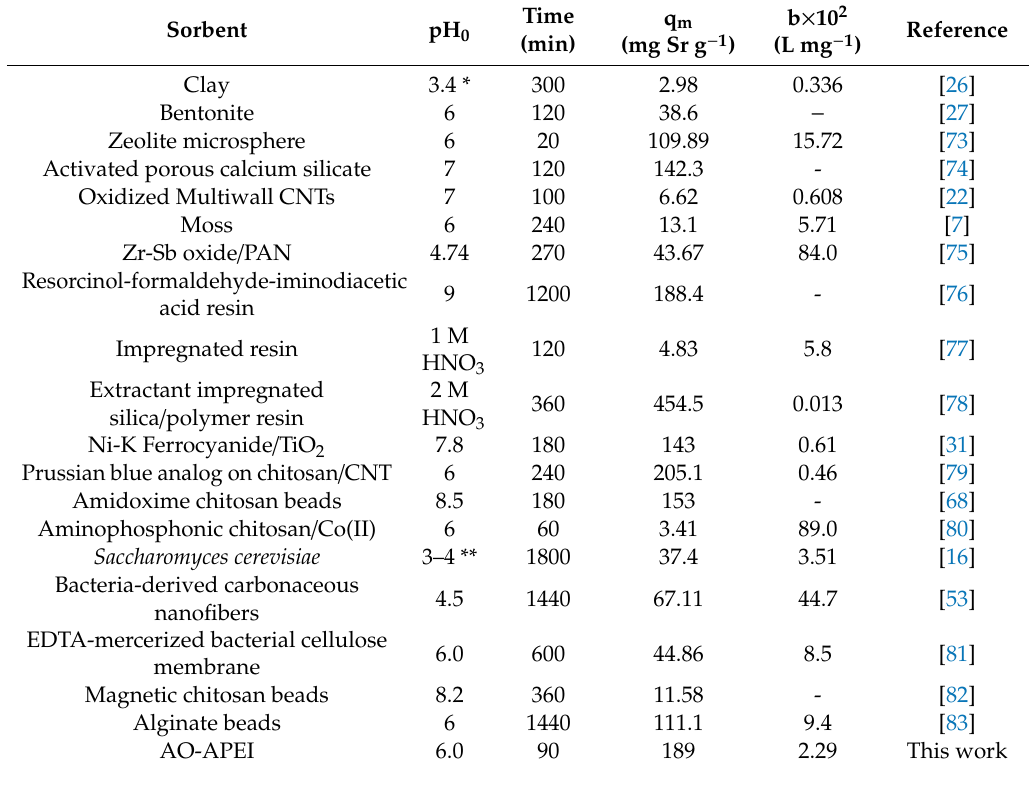
Table 3. Comparison of Sr(II) sorption properties for various